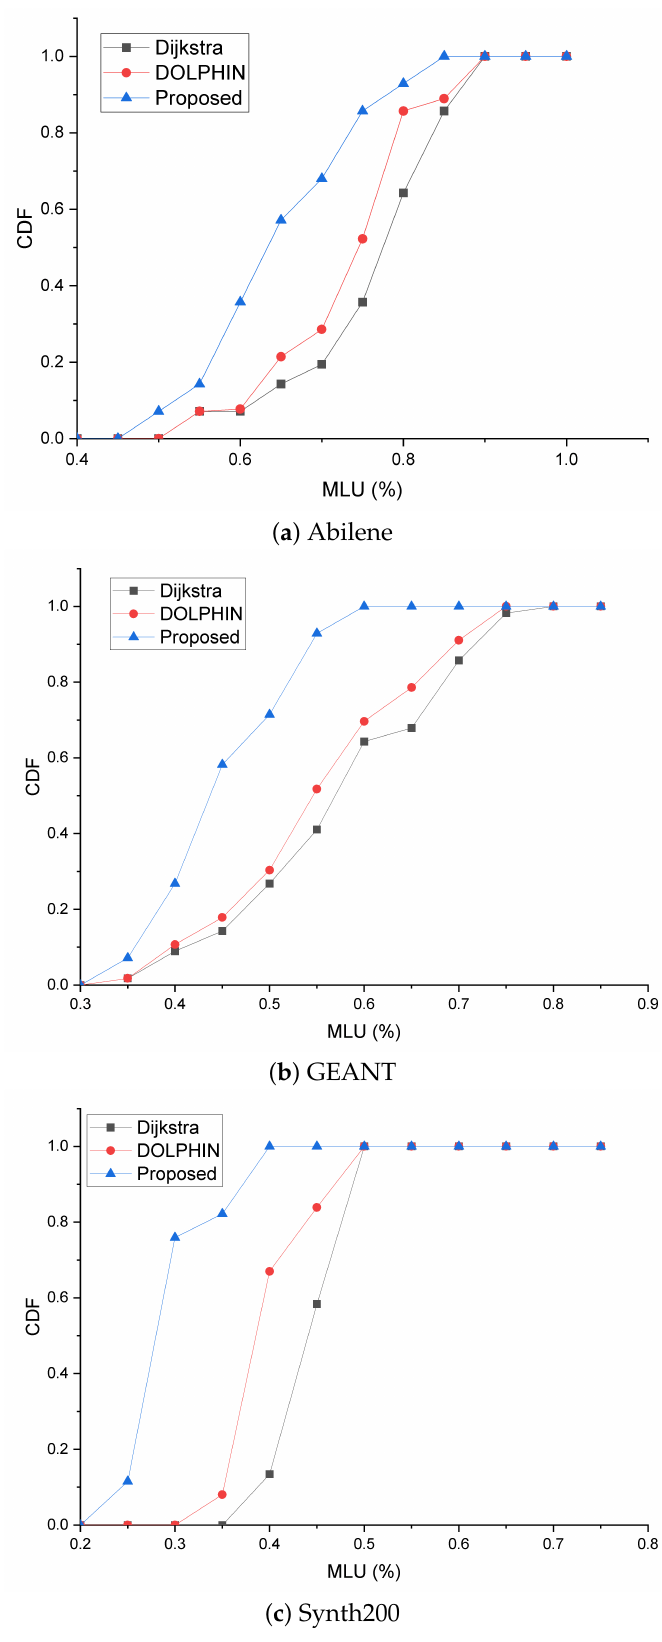
Figure 7. Link utilization